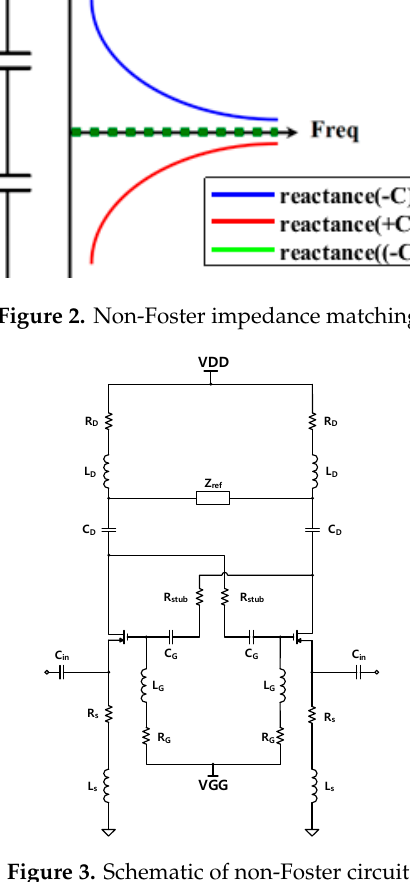
Figure 3. Schematic of non-Foster circuit.